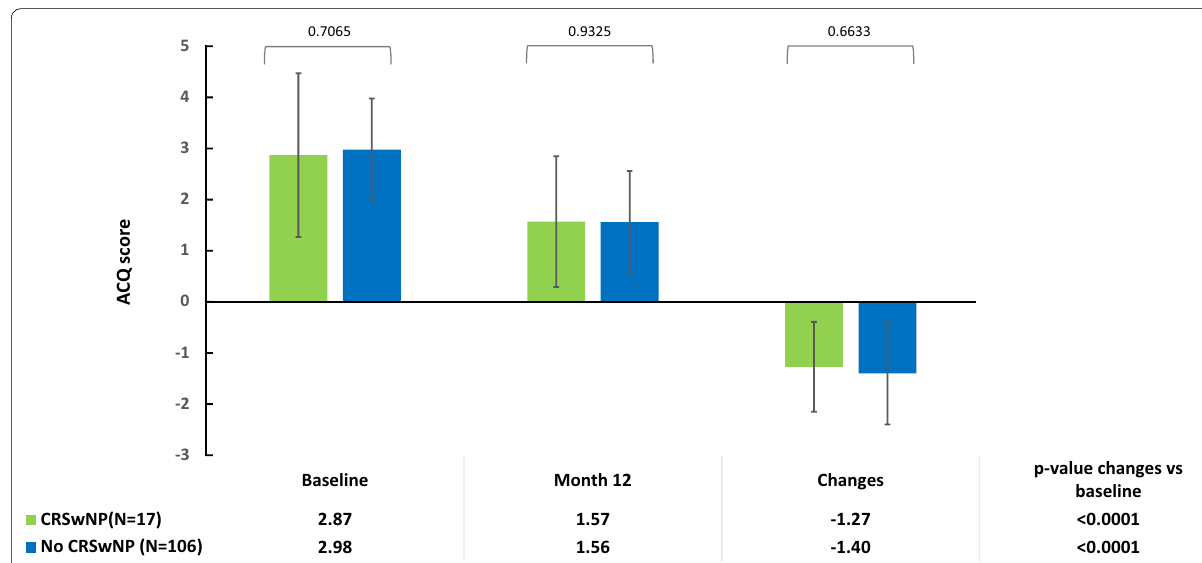
Fig. 1 Mean (standard deviation) Asthma Control Questionnaire scores at baseline and 12 months after omalizumab treatment, and the change from baseline in ACQ score, in patients with severe allergic asthma, with chronic rhinosinusitis with nasal polyps (CRSwNP) or without CRSwNP (No CRSwNP). The p-values within cohorts were calculated using a signed rank test and p-values for comparisons between cohorts were calculated using an ANCOVA model on